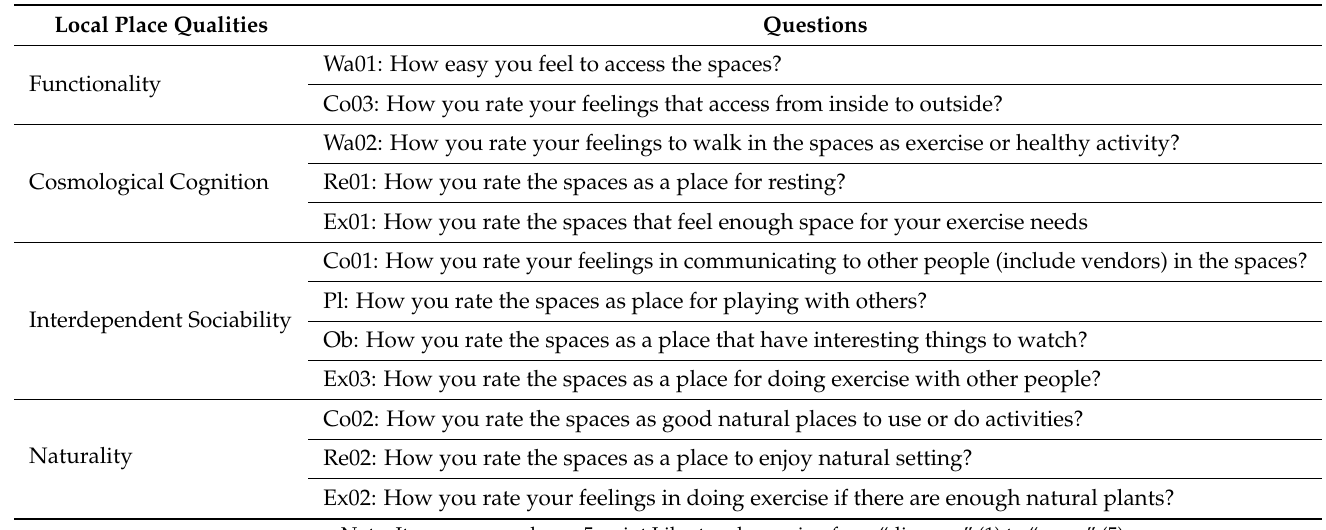
Table 6. Interview questions for identifying local perceptions of the use of public spaces. Local Place Qualities